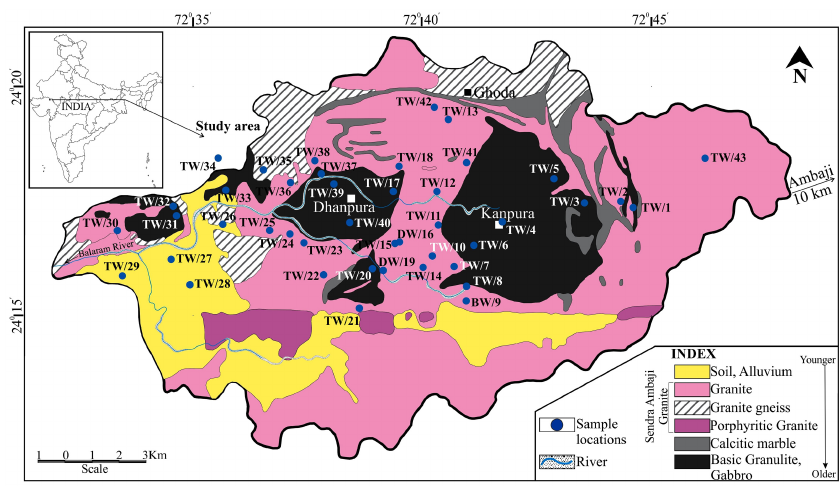
Figure 1. Geological map and sample locations of the study area (modified after Singh et al., 2010).